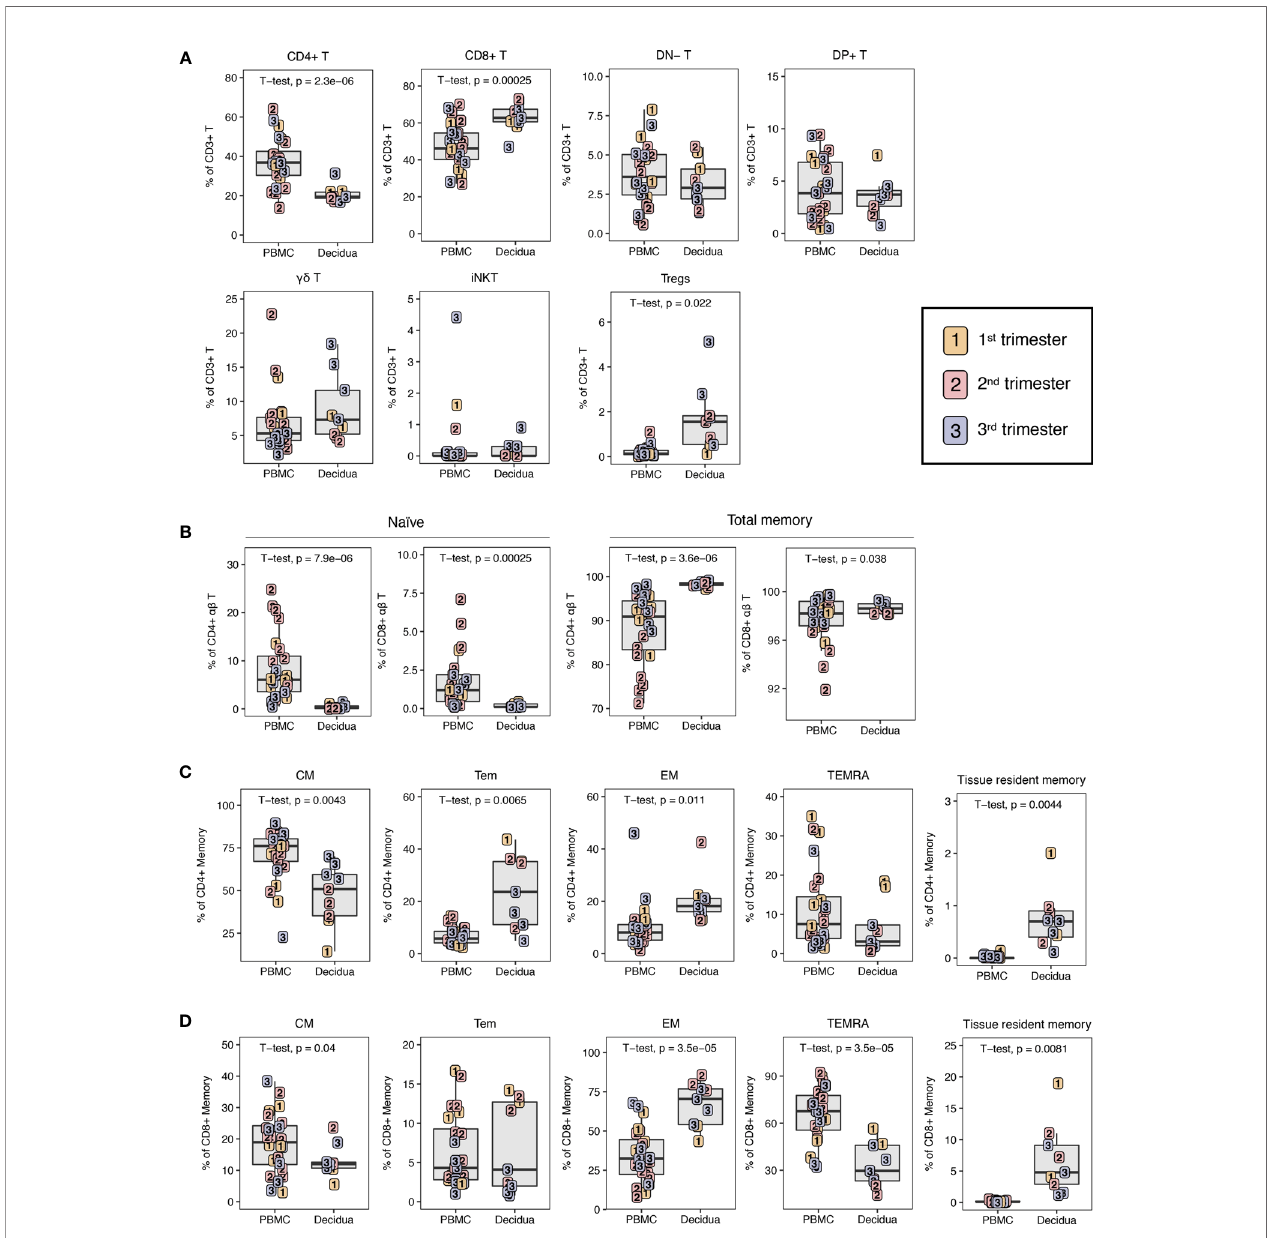
FIGURE 4 | T lymphocyte composition in PBMC and decidua from fi rst to third trimester in normal pregnant rhesus macaques. (A) Frequency of conventional and innate T cells in fi rst (yellow), second (red) and third trimester (blue) of pregnancy in PBMC and decidua of normal rhesus macaques. (B) CD4+ T and CD8+ T naive and total memory. (C) CD4+ T memory subsets. (D) CD8+ T memory subsets. P-values <0.05 (unpaired t-test) shown on the